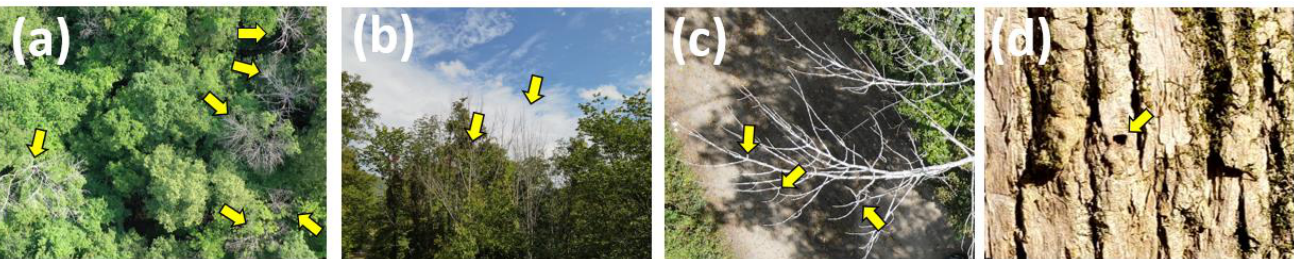
Figure 1. Example aerial view of declining or dead ash trees from aerial images obtained with drones ( a ), ground view of declining or dead ash trees ( b ), and a noticeable opposite branching pattern of ash trees on the aerial images ( c ). The ground survey confirmed the presence of emerald ash borers with adults’ exit holes ( d ). Yellow arrows in ( a , b ) indicate declining and dead ash trees, and arrows in ( c , d ) indicate an opposite branching pattern and D-shaped exit holes made by adult emerald ash borers, respectively.